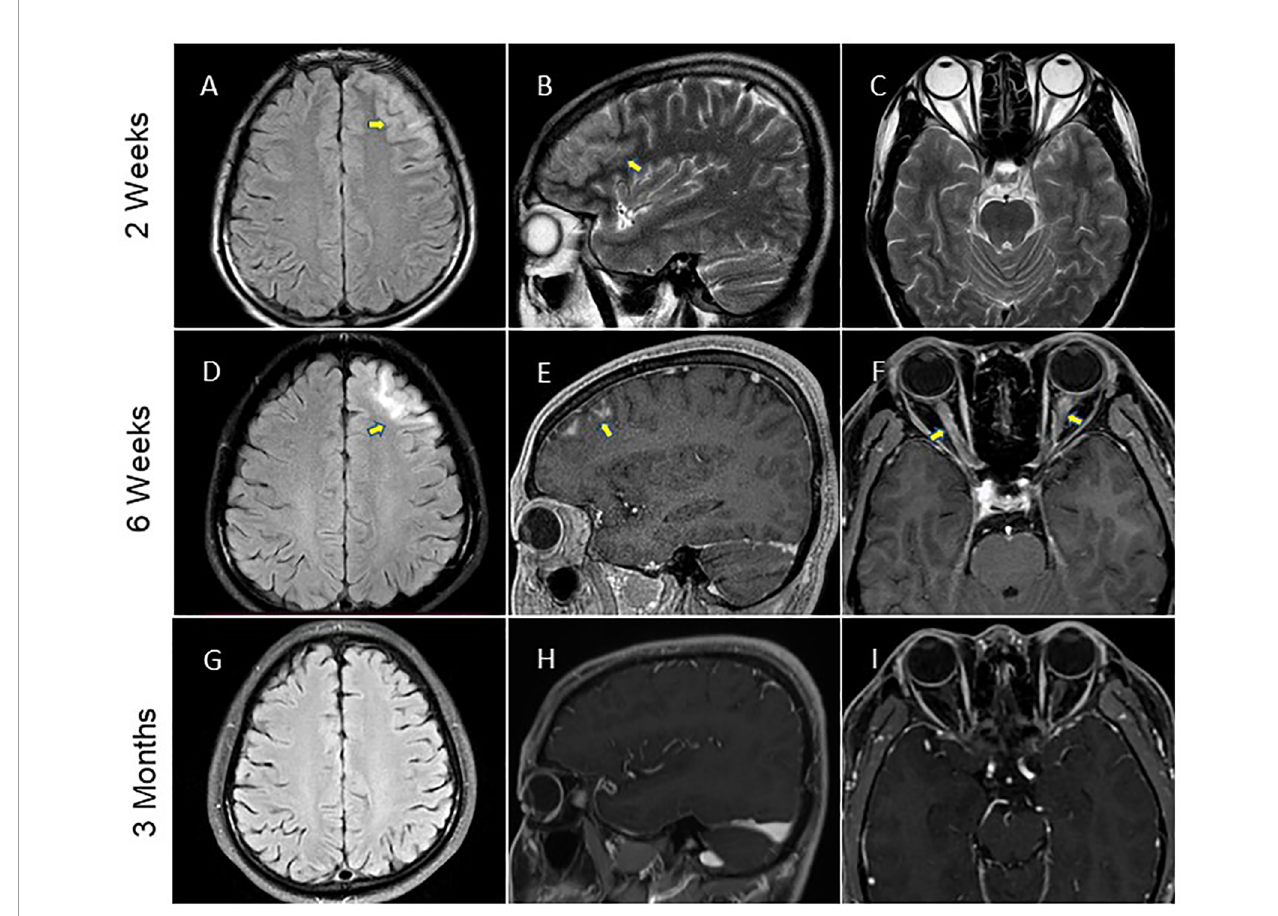
FIGURE 1 | Brain MRI performance. (A – C) The MRI data of patient at two weeks after the symptom onset showed hyperintensity of the left frontal lobe on fl uid- atten uated inversion recovery (FLAIR) imaging and T2-weighted imaging (arrows). (D – F) MRI of the brain was repeated at 6 weeks and showed enhancement of the left frontal lobe lesion involved the bilateral optic nerve (arrows) on FLAIR imaging conducted with gadolinium contrast. (G – I) Brain MRI scan performed at three months after initial symptom onset depicted a signi fi cant improvement of the imaging